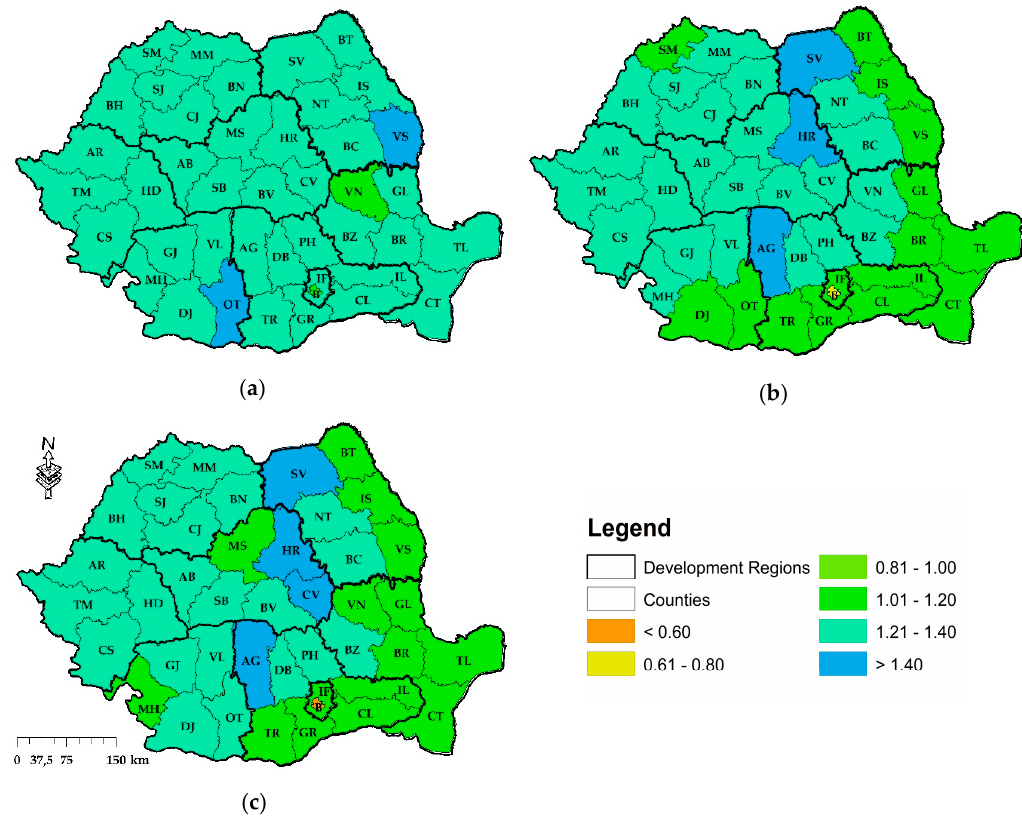
At the county level, the smallest fractal dimensions of forested areas (indicating lower